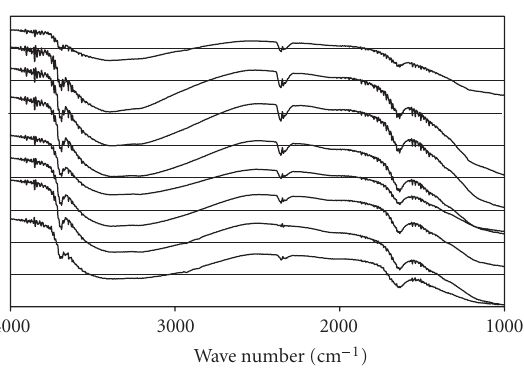
Figure 7: FTIR spectra for A11 photocatalyst samples. From bot- tom to top: untreated P25, P25/700 ◦ C, P25/750 ◦ C, P25/800 ◦ C,